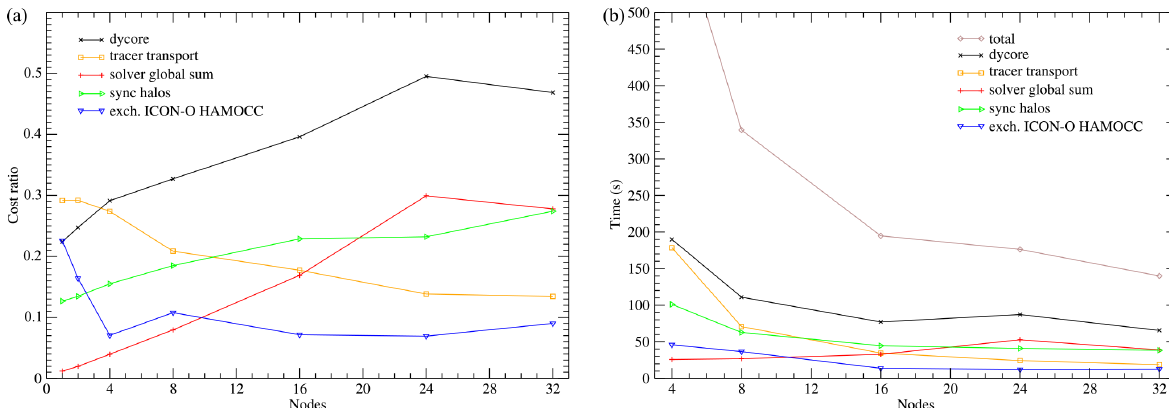
Figure 15. (a) Relative costs of the ICON-O components in the concurrent 40km setup. (b) Run times for each component.